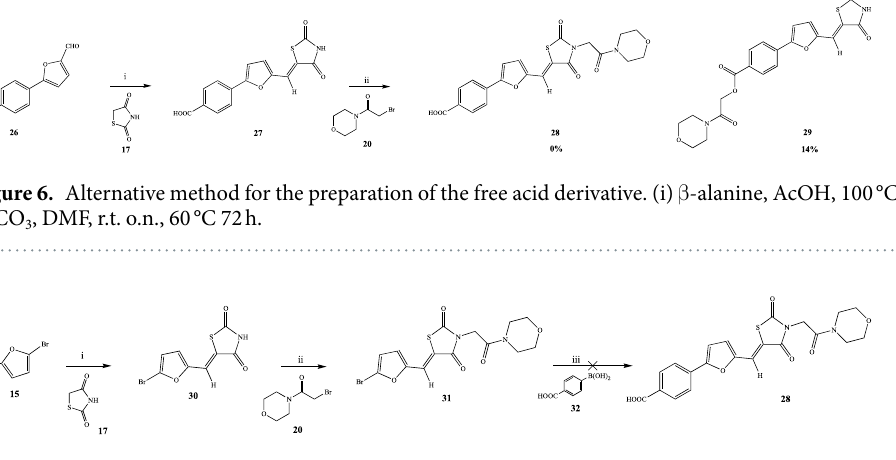
Figure 7. Alternative method for the preparation of the free acid derivatives (i) β -alanine, AcOH, 100 °C 1 h; (ii) K 2 CO 3 , DMF, r.t. o.n., 60 °C 72 h; (iii) Na 2 CO 3 , Pd(PPh 3 ) 2 , THF/H 2 O, r.t. 8 h, 60 °C 12 h.